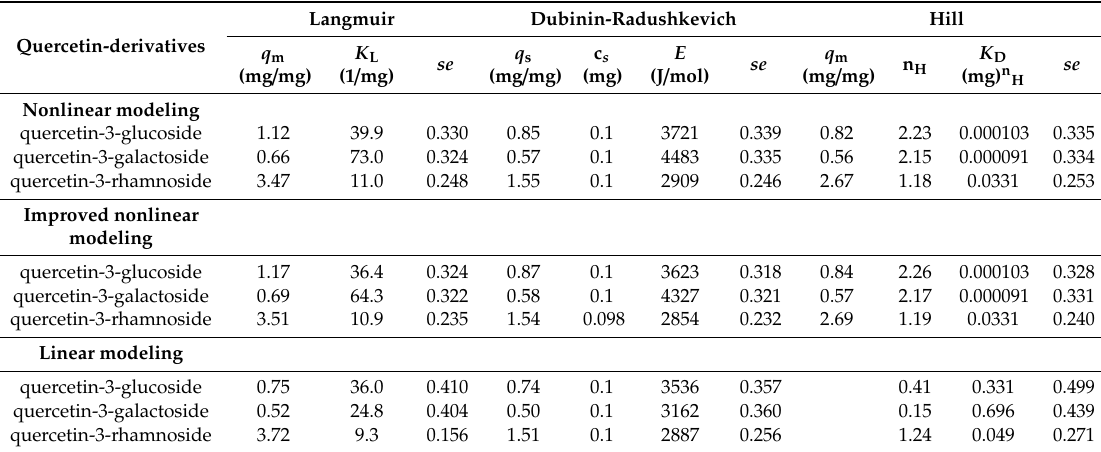
Table 3. Parameters of adsorption isotherms of quercetin derivatives adsorption onto β -glucan obtained fromnon-linear*(standardandimproved)andlinear*equationofLangmuir’s, Dubinin-Radushkevich’s and Hill’s equations.